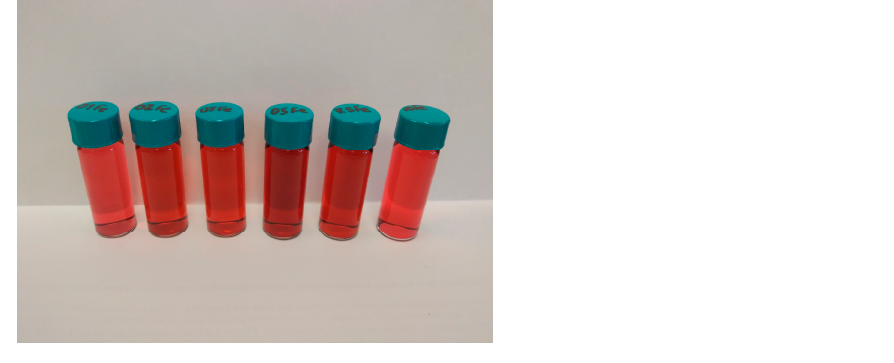
Figure A2. Photograph of samples with 100 ppm Fe with 1, 2, 3, 5, 7.5, and 10 times as many moles of Bipy added respectively, from left to right in HNO 3 solution.